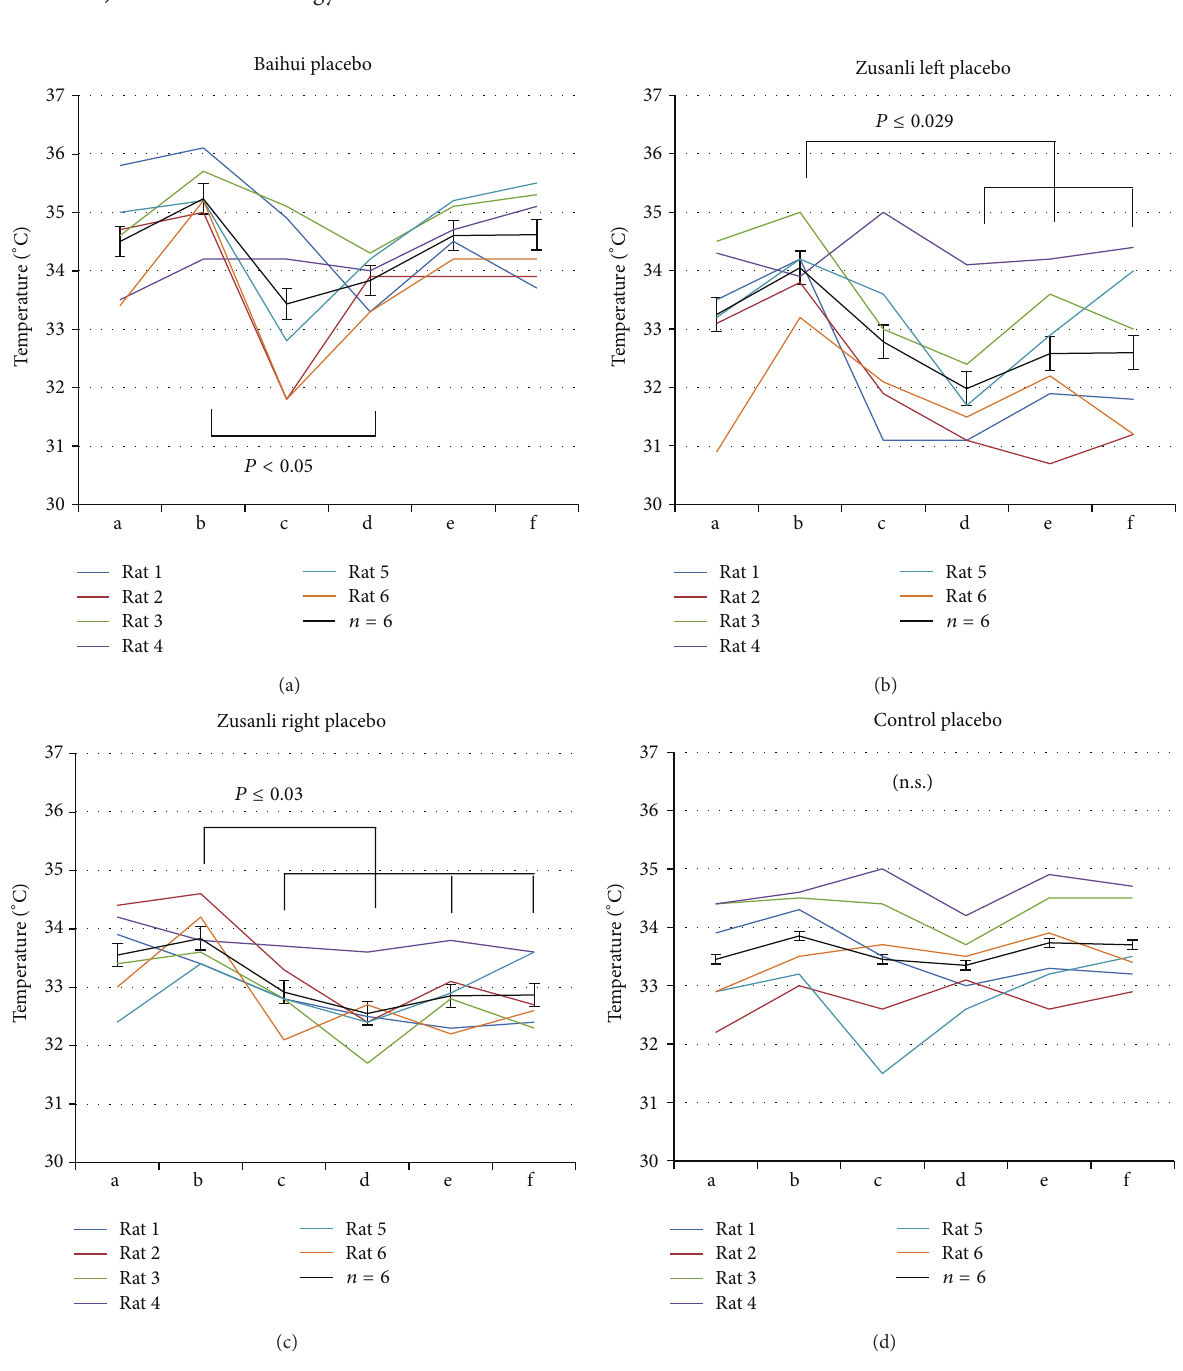
the results cannot be compared with our continuous wave mode. In addition, not only surface stimulation on the rat skull but also direct brain infrared neural stimulation was recently (in 2013) performed by Liljemalm et al. [14]. Due to the different technical parameters in their study, the results also cannot be compared to our present